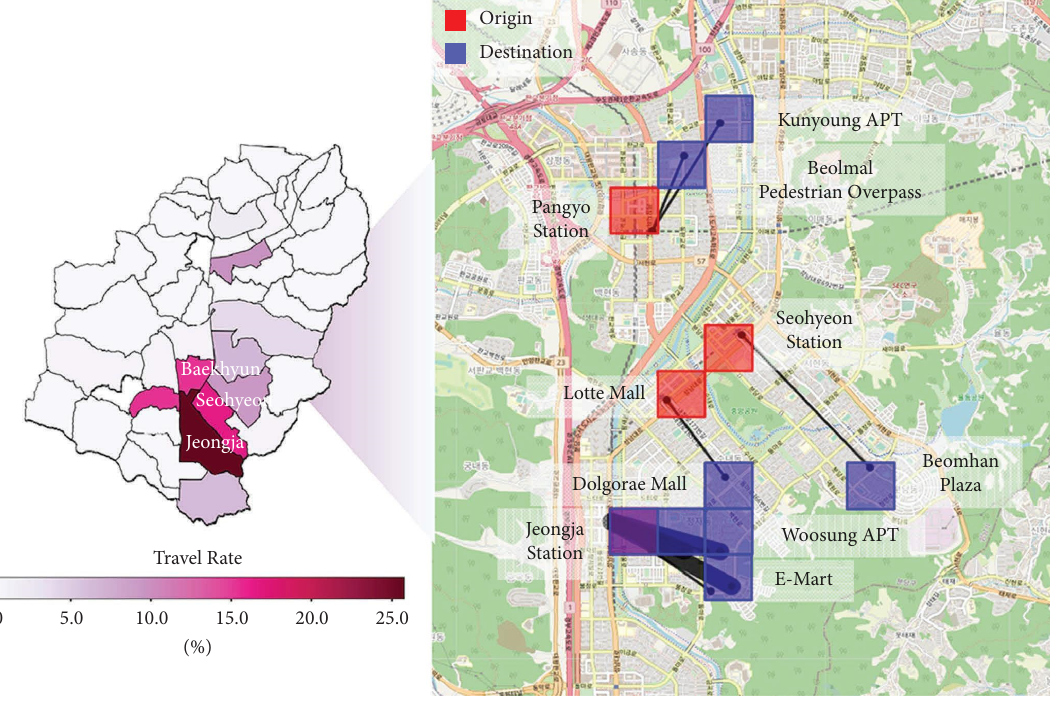
Figure 7: Top ten OD pairs of cluster 3.